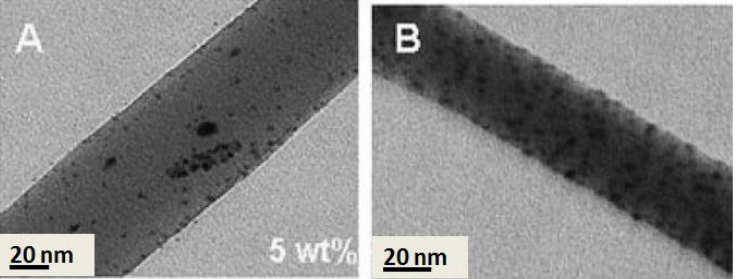
Figure 12. TEM images of cellulose acetate nanofibers containing 5 wt% AgNO ( A ) before UV irradiation and ( B ) after UV irradiation